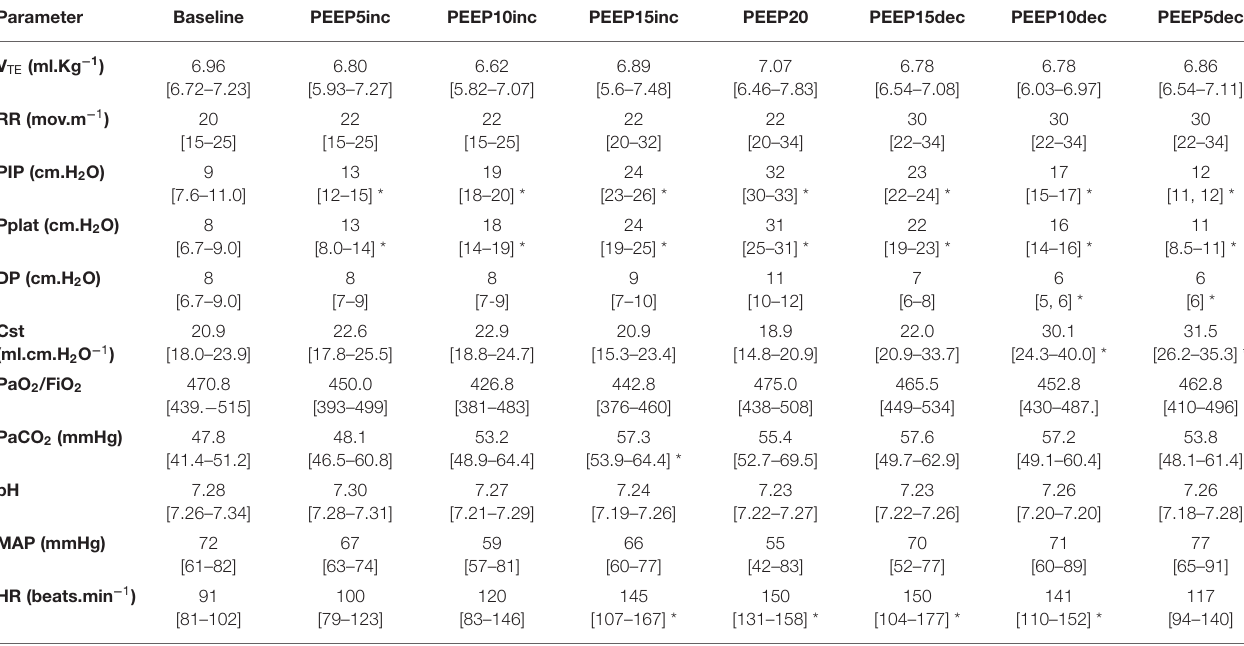
TABLE 2 | Lung mechanics, gas exchange and hemodynamics